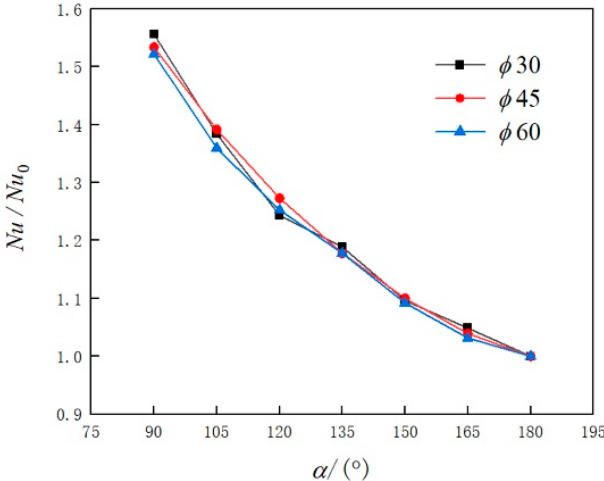
Figure 10. Relative Nusselt number Nu / Nu 0 changing with the central angle α for straight pipes.